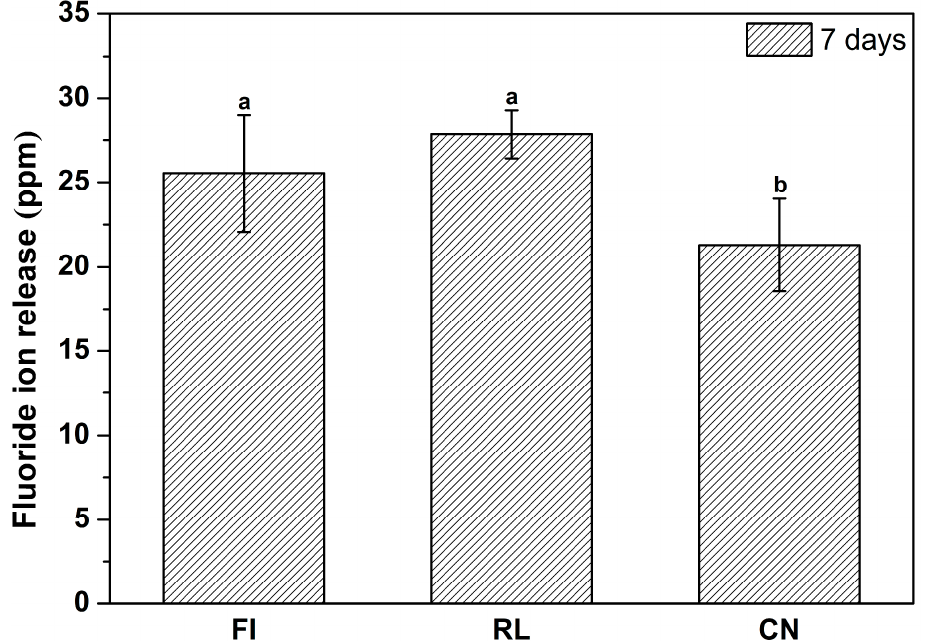
Figure 3. Fluoride ion release from the studied materials for 7 days. Each value indicates the mean of 6 measurements, and the error bars represent the standard deviation of the mean values (mean ± standard deviation; n = 6). Differences in lowercase letters above the bar graph indicate significant differences between each group ( p < 0.05).